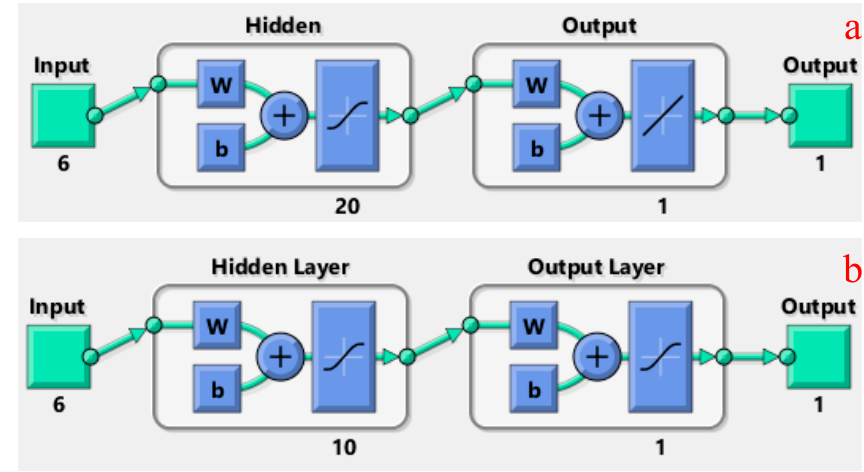
Figure 2. Structure of the artificial neural network used in this study ( a ) for CH 4 emissions ( b ) for N 2 O emissions.